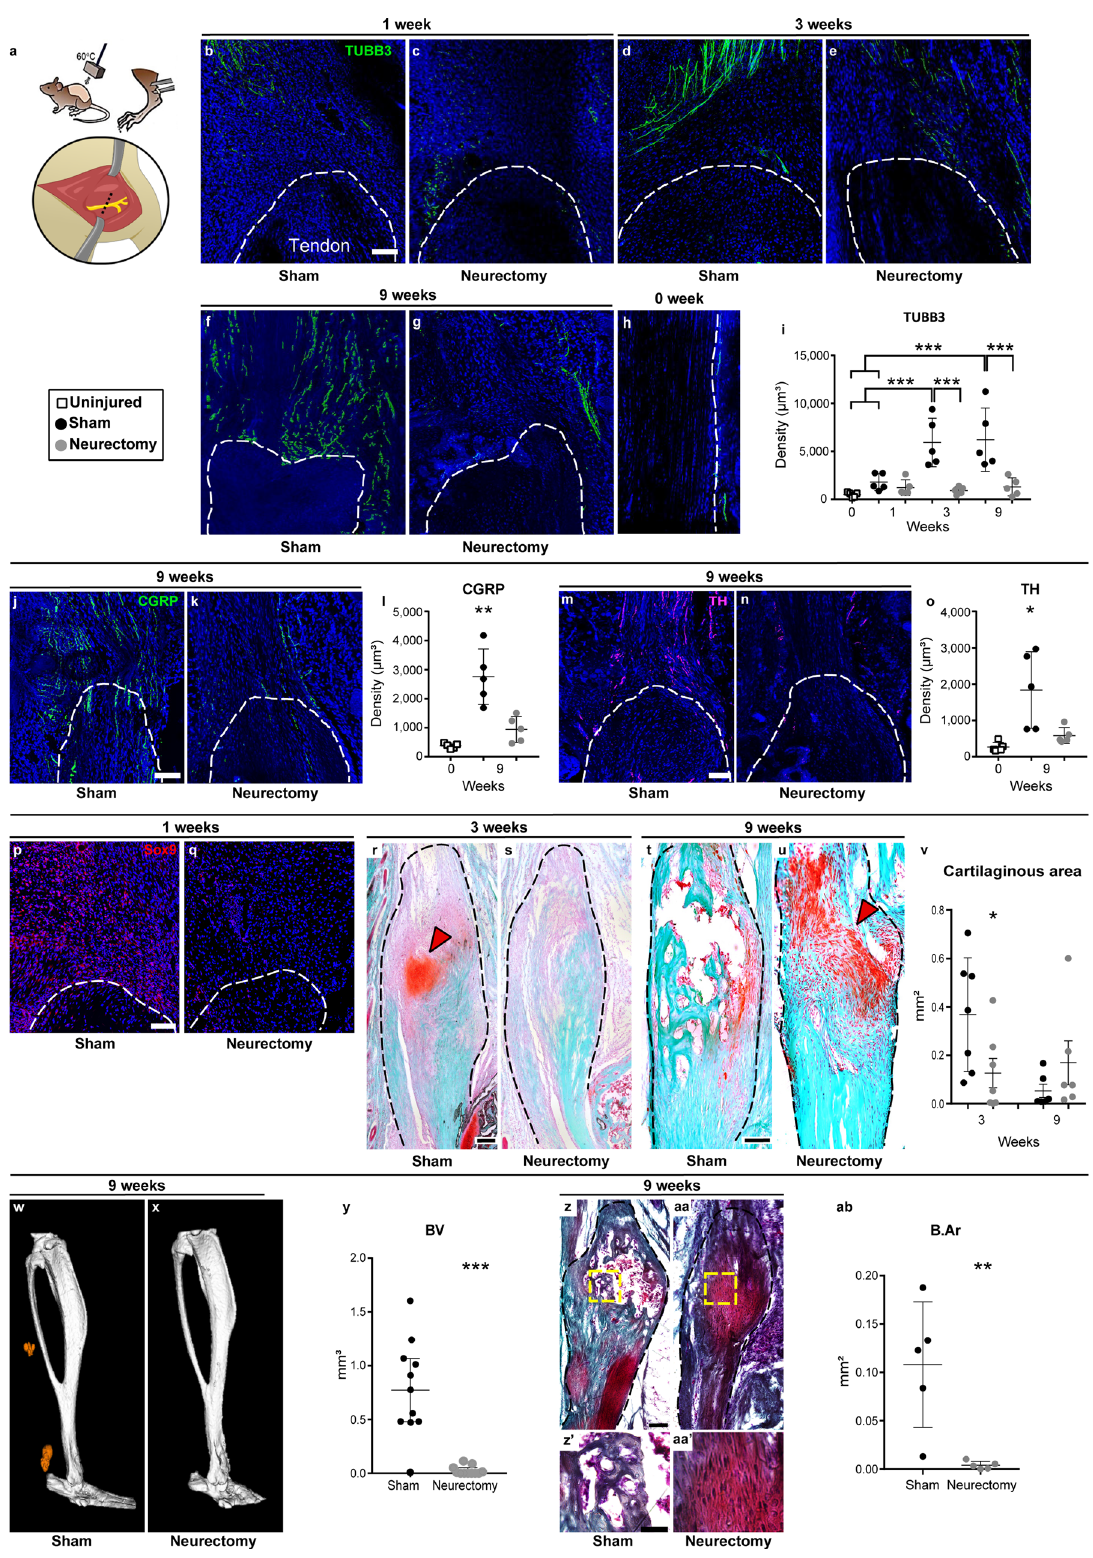
distal tenotomy site in comparison to uninjured limbs (Fig. 4a). Within the uninjured Achilles tendon, essentially no NGF reporter activity was observed within the tendon body, and inconspicuous reporter activity was present within the surround- ing soft tissue (Fig. 4b). One week after tenotomy and during the fi broproliferative phase, conspicuous NGF reporter activity